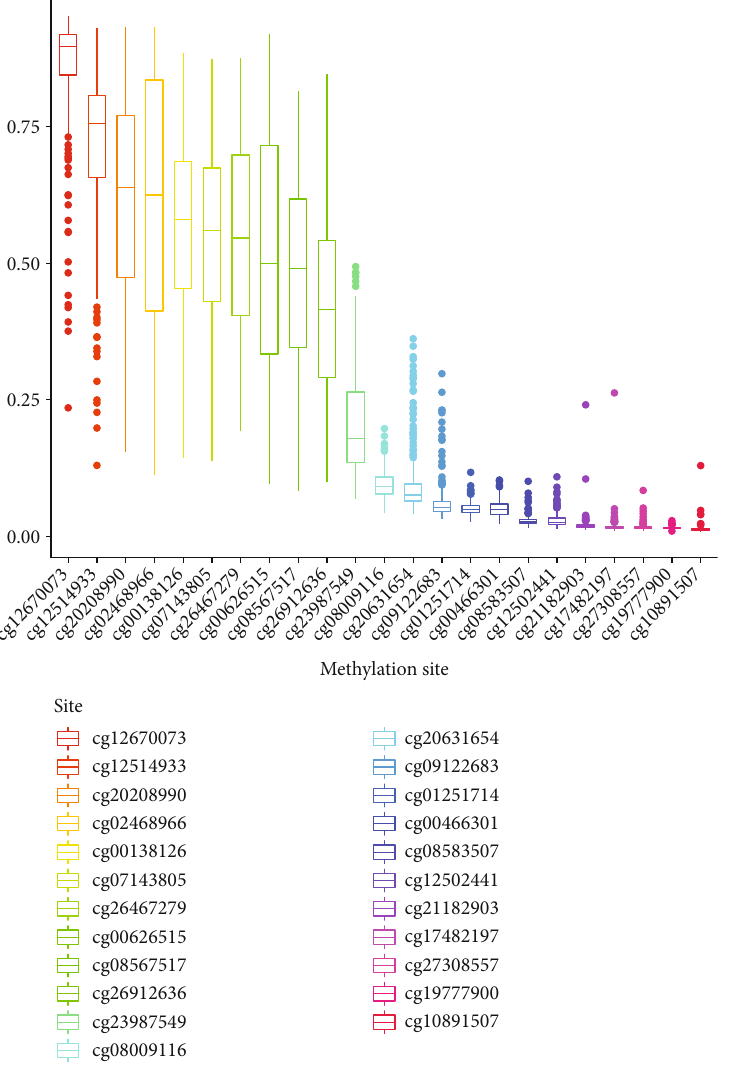
Figure 2: The distribution of 23 PMEPA1 DNA promoter CpG